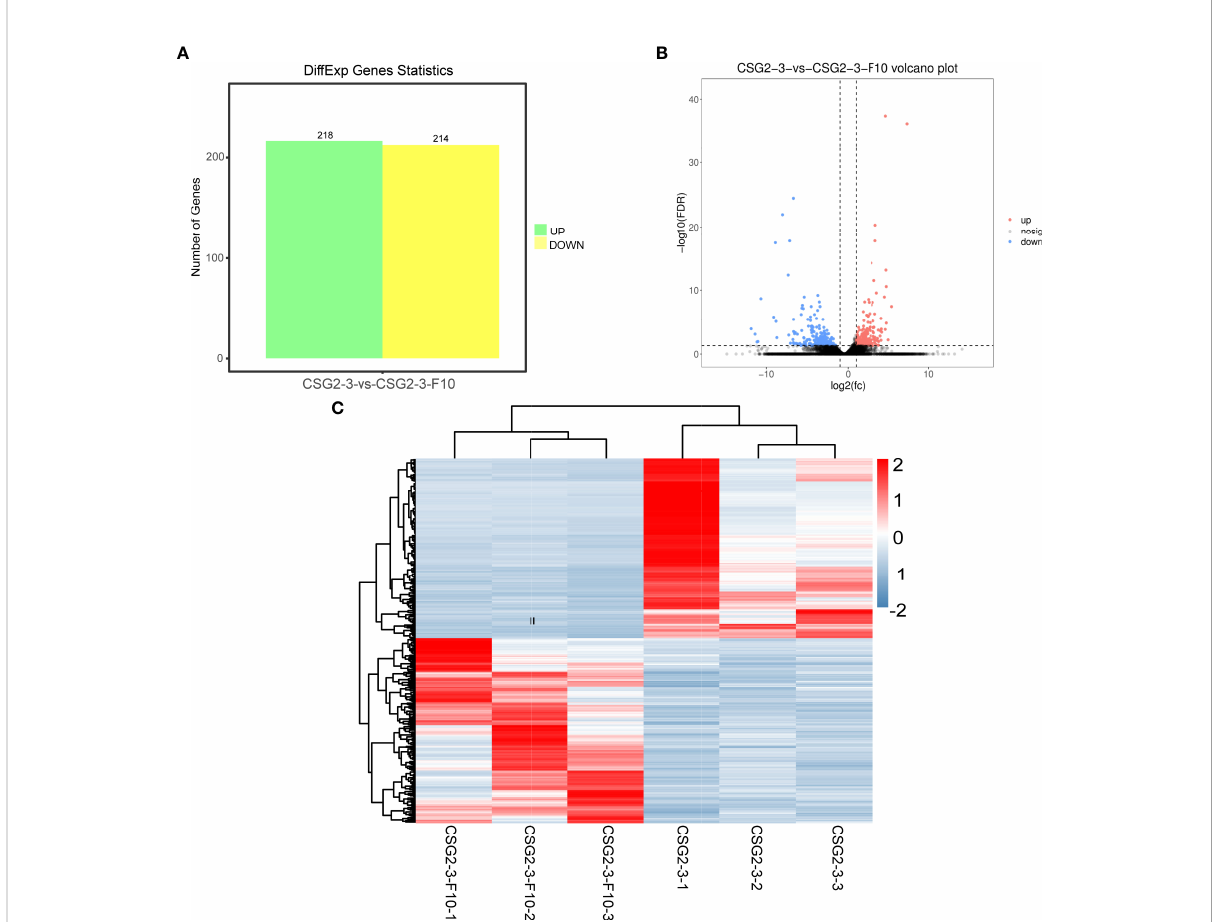
FIGURE 6 Differentially expressed genes between CSG2-3 and CSG2-3-F10. (A) Number of DEGs between CSG2-3 and CSG2-3-F10. The green column represents upregulated DEGs, and the yellow column represents downregulated DEGs. (B) The volcano plot of DEGs between CSG2-3 and CSG2-3-F10 displays – log10 (FDR) on the Y-axis, index of gene differences from NOIseq, and Log2 (fold-change (FC)-value) on the X-axis. The pink dots represent upregulated DEGs, and blue dots represent downregulated DEGs between CSG2-3 and CSG2-3-F10. Black dots indicate genes without statistical signi fi cance. (C) Heatmap of DEGs between CSG2-3 and CSG2-3-F10. The abscissa represents the CSG2-3 vs. CSG2- 3-F10 differential genes, and the left lines represent the clustering relationship between genes. The above lines represent the clustering relationship between samples. After Z-SCOR homogenization of gene expression, the color changed from blue to red, indicating that the expression of this gene in this sample changed from low to